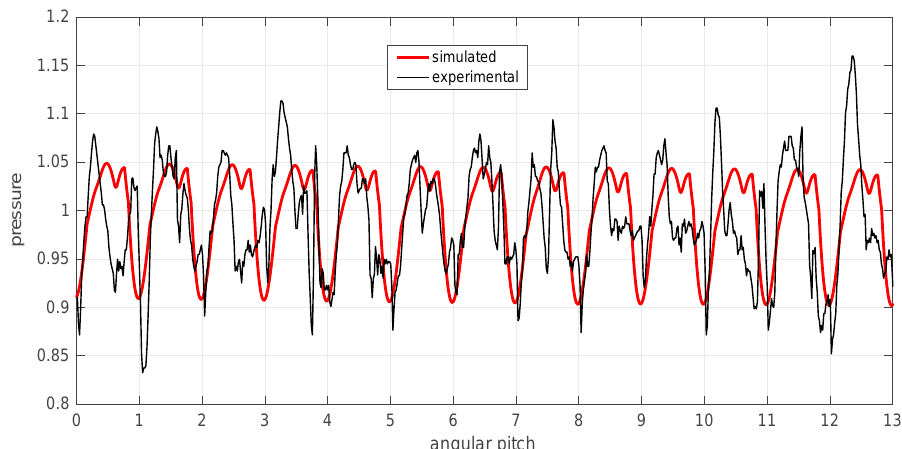
Figure 21. Simulated and experimental instantaneous delivery pressure at 2000 rpm, 3 bar and 65 °C.